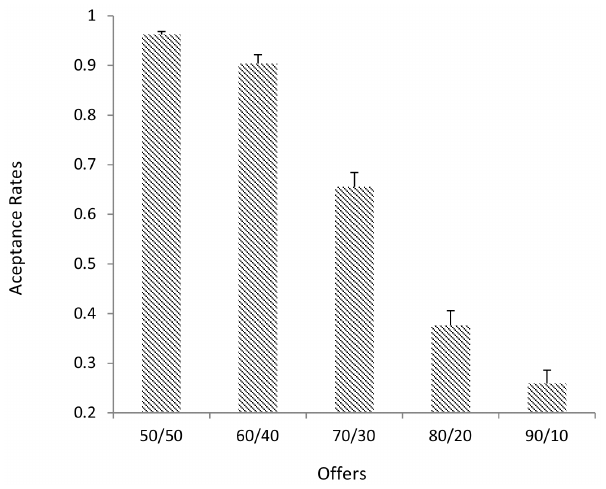
Figure 2. Average Acceptance Rates For Different Offers. Error bars = standard error of the mean.